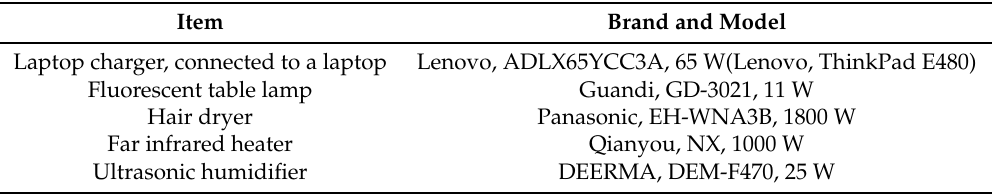
Table 1. The brand and model of the tested